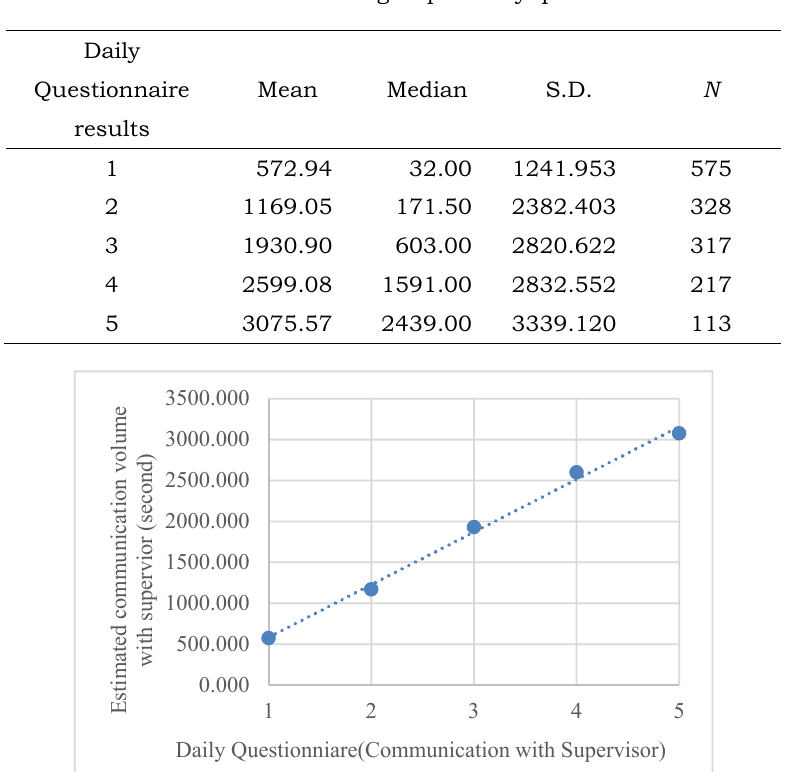
Figure 6. The relation between daily questionnaire results and estimated communication